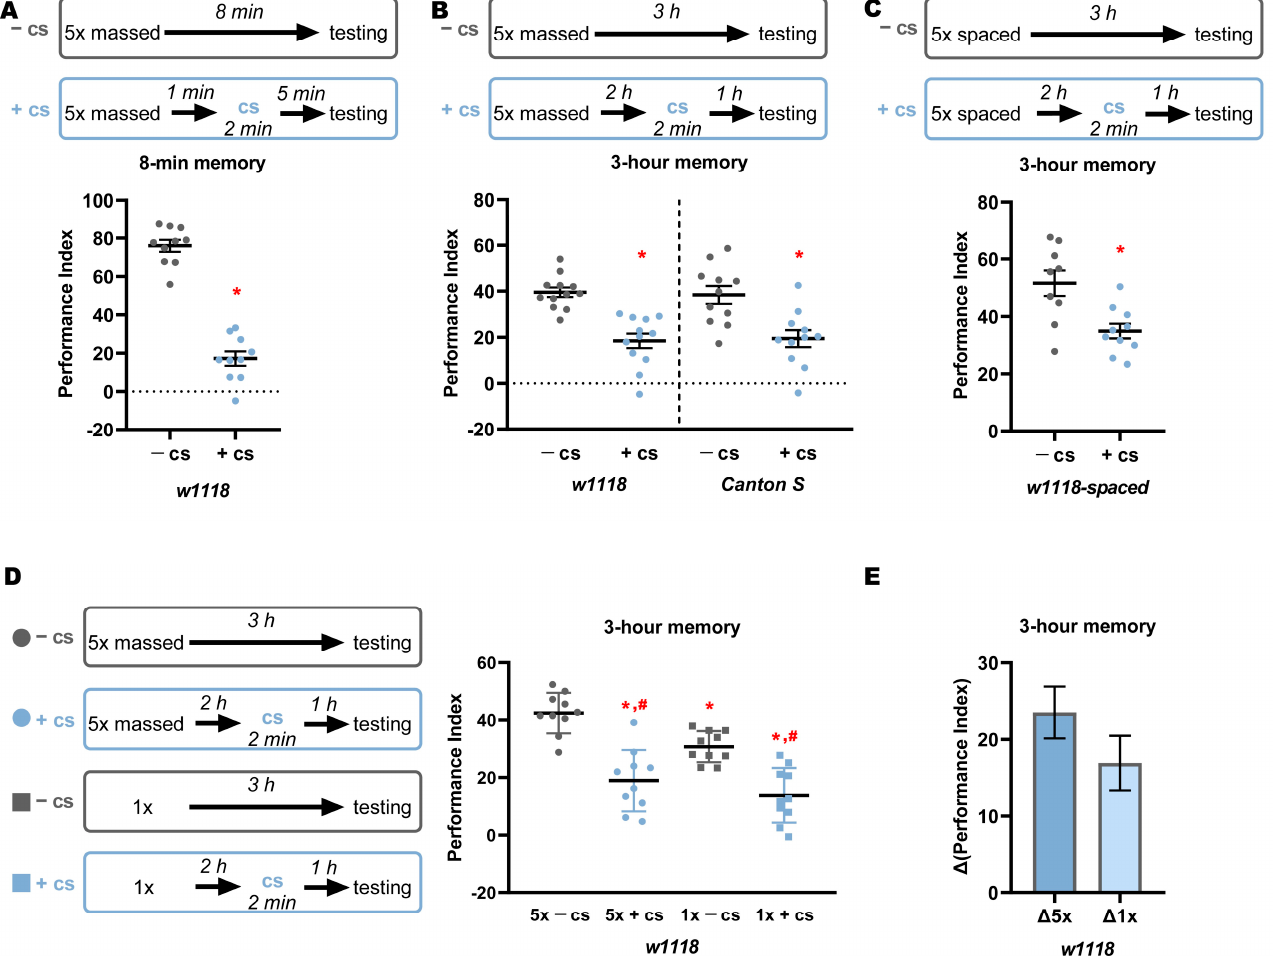
Figure 1. Memory acquired by massed training is cold-shock sensitive. The graphs show mean performance ± SEM consequent to the treatments detailed above. Star and pound symbols indicate significant differences as detailed below. ( A ) An 8-min (immediate) memory of w 1118 animals is inhibited by a 2-min by cold shock (ANOVA F (1,20) = 144.82, p < 4.8 × 10 − 10 ). ( B ) Three-hour memory produced by massed training is significantly reduced by cold shock treatment in both w 1118 (ANOVA F (1,24) = 30.74, p < 1.4 × 10 − 5 ) and Canton S (ANOVA F (1,22) = 12.41, p = 0.002) animals. ( C ) Three-hour memory of w 1118 animals after spaced training is significantly affected by cold shock (ANOVA F (1,19) = 10.87, p = 0.004). ( D ) Three-hour memory in w 1118 flies after one training round is different from memory formed after five consecutive rounds [(ANOVA F (3,40) = 23.05, p = 1.7 × 10 − 8 ). Subsequent analysis using LSM-planned comparisons revealed that the difference between the two groups is indeed significant ( p = 0.003, star)]. The performance of cold shocked flies was signifi- cantly different from that of untreated animals after one or five MC rounds ( p < 0.0001, pound). However, memories resilient to cold shock were not significantly different ( p = 0.1856). ( E ) Differ- ences in indexes shown in ( D ) between treated and non-treated groups that were simultaneously trained with five or one training round are not significantly different (ANOVA F (1,20) = 1.79, p = 0.1965).